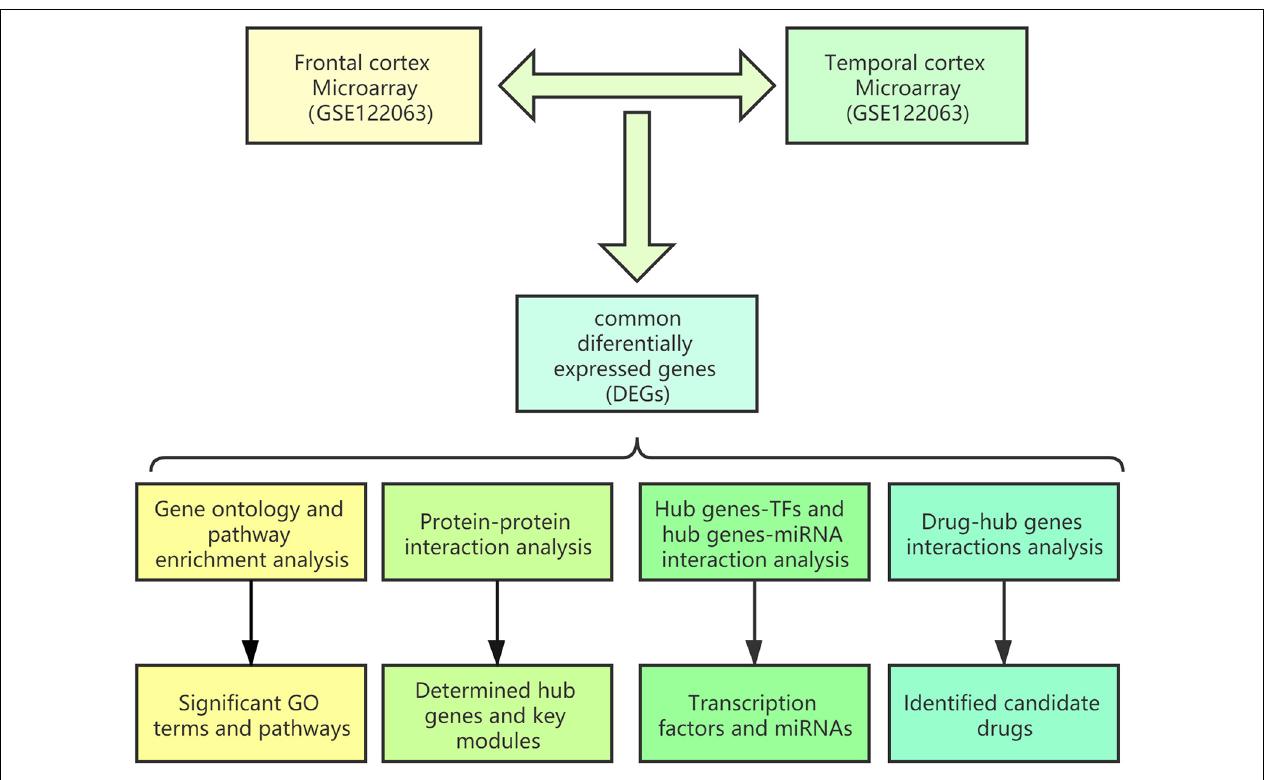
FIGURE 1 | Schematic diagram of the workflow of the bioinformatics analyses conducted in this study.